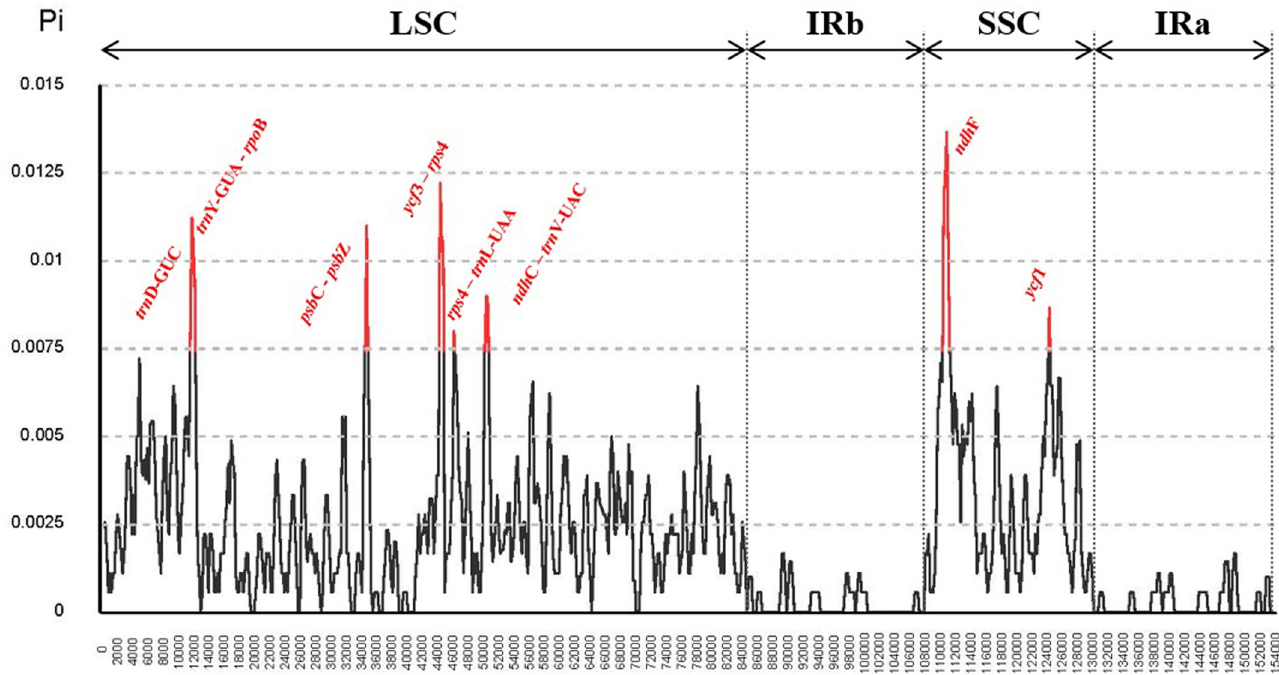
Fig 5. Sliding window of nucleotide diversity from the alignment of six Cirsium plastomes.